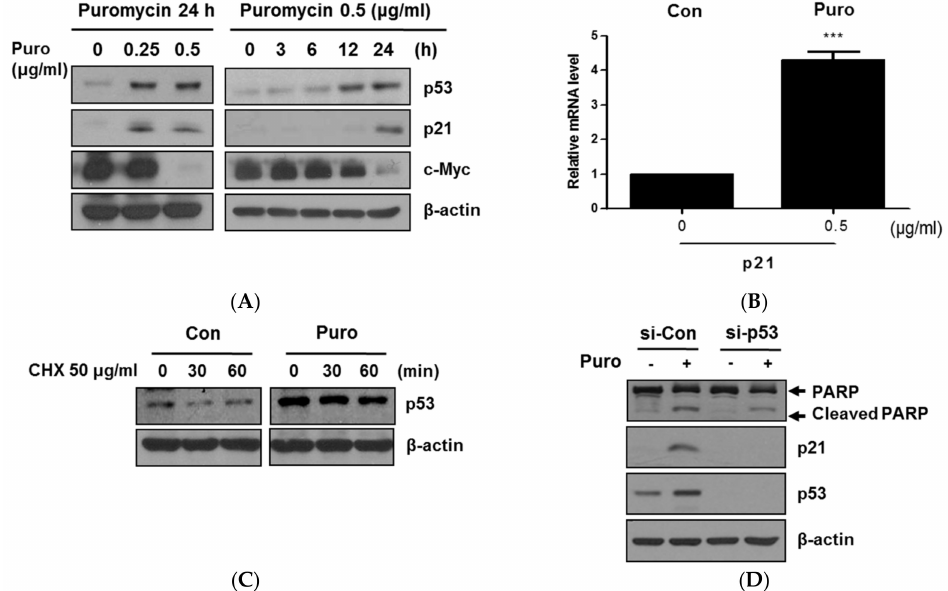
Figure 3. Puromycin induced p53-dependent apoptosis in HCT116 cells. ( A ) E ff ect of puromycin on p53, p21, and c-Myc in a concentration and time-dependent manner in HCT116 cells. HCT116 cells were exposed to various concentrations of puromycin (0.25 or 0.5 µ g / mL) for 24 h and then subjected to Western blotting with antibodies of p53, p21, and c-Myc. Also, HCT116 cells were treated with 0.5 µ g / mL puromycin for 6, 12, or 24 h and subjected to Western blotting. ( B ) E ff ect of puromycin